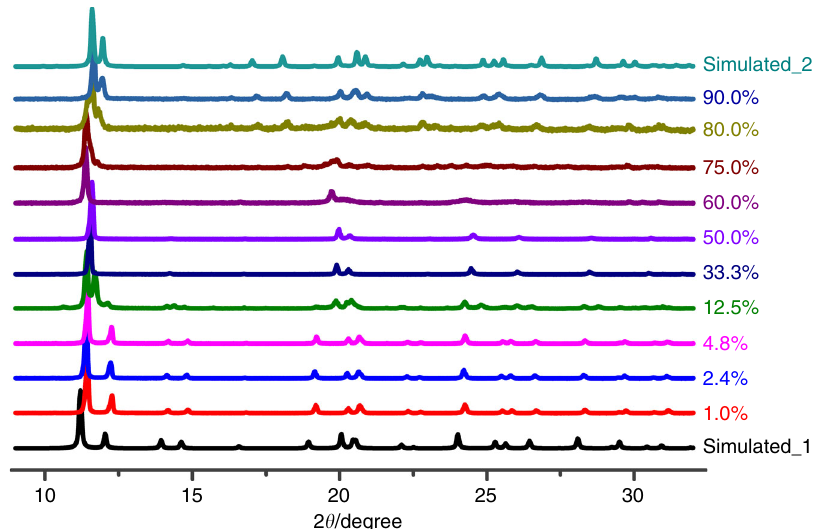
Fig. 8 Room temperature PXRD patterns for the CP solid solutions {1 1-x 2 x }. The mixing ratio ( x ) of CP 2 in these solid solutions increases from 1.0 to 90.0%.